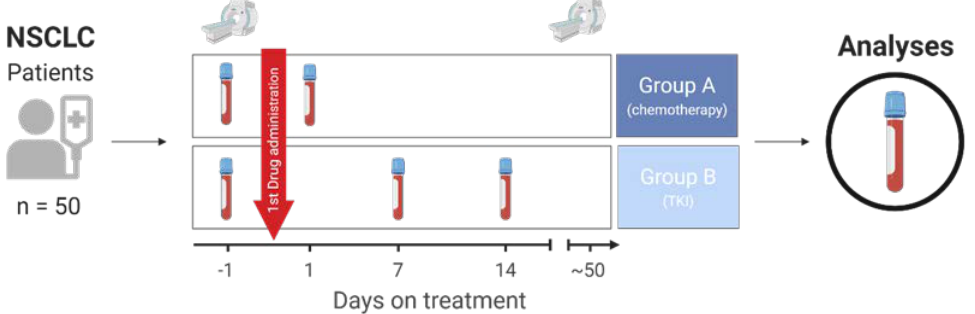
Figure 1. Description of the study concept. Blood from 50 patients with non-small cell lung cancer (NSCLC) was collected at baseline one day prior to therapy start (day − 1) and after therapy initiation (day + 1 for group A, day + 7 and + 14 for group B). Routine computer tomography (CT) at baseline and at time point of first clinical restaging was evaluated for tumor load change. Restaging CT was assessed in median at day 50. TKI: tyrosine kinase inhibitor.